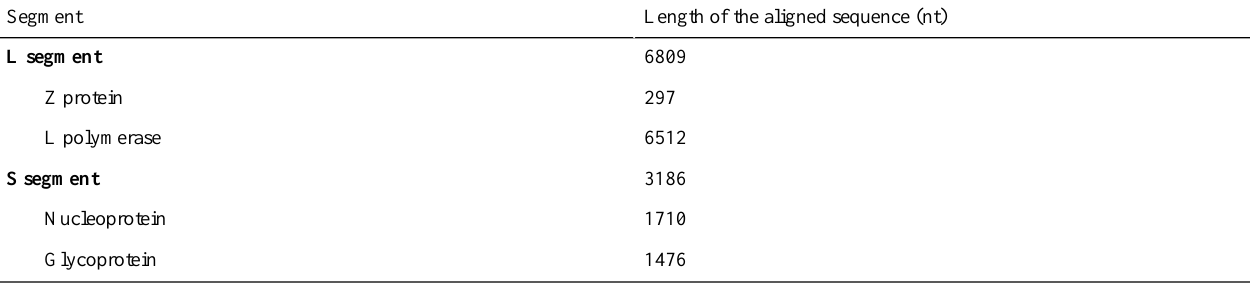
Table 2. Sequence length (nt) of aligned segment and gene sequences after gap removal.